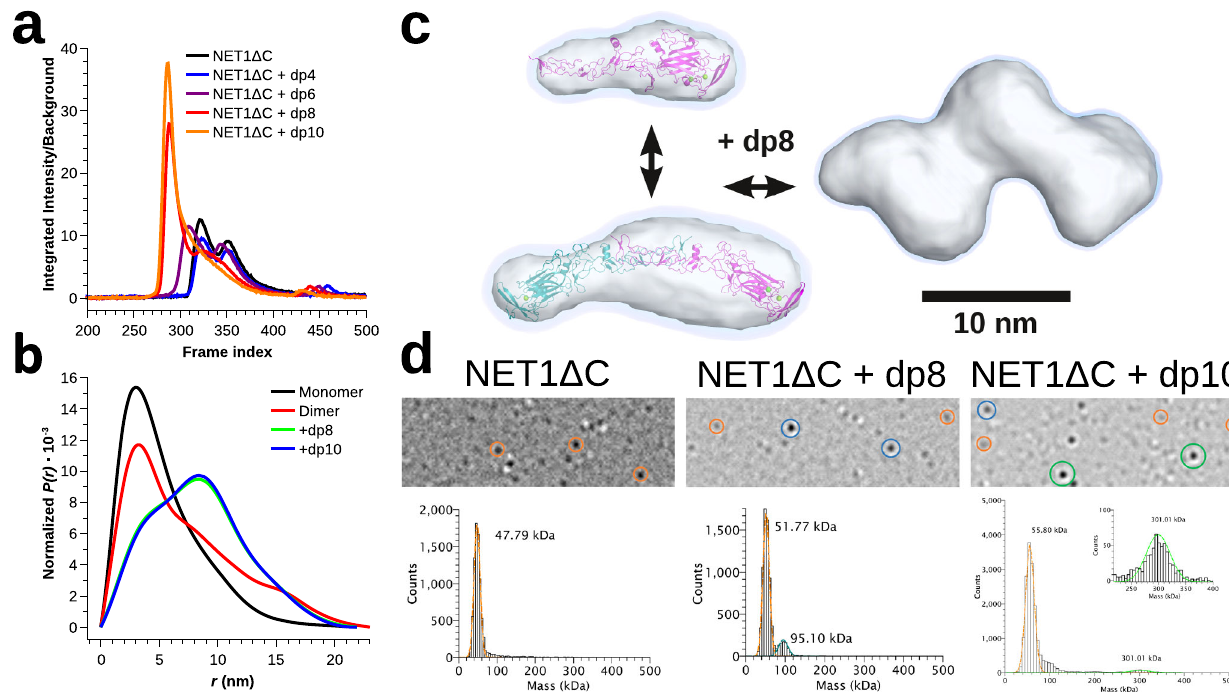
Fig. 5 | Dynamic nature of NET1 Δ C - SEC-SAXS and mass photometry. a SEC- SAXS X-ray scattering trace of NET1 Δ C while eluting from the SEC column. Pure interval, Supplementary Table 5c, d) which agrees with the SEC-MALS measure- ments of 235kDa (Supplementary Table 2, Fig. 4a). b P(r) distributions calculated from the scattering pro fi les. c ED reconstruction from the scattering pro fi les of monomeric and dimeric NET1 Δ C and upon addition of HO-dp8. The blue-shaded